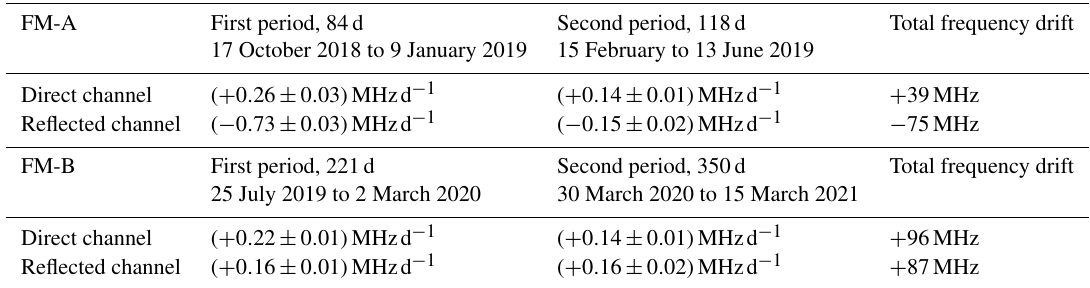
Table 4. Frequency drift rates and total frequency drift obtained for the direct channel and the reflected channel over two periods of operation for FM-A and FM-B as shown in Fig.